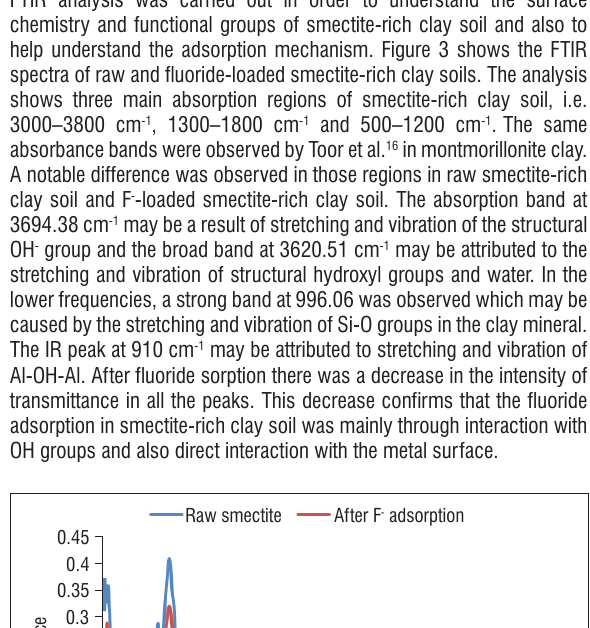
X-ray fluorescence analysis